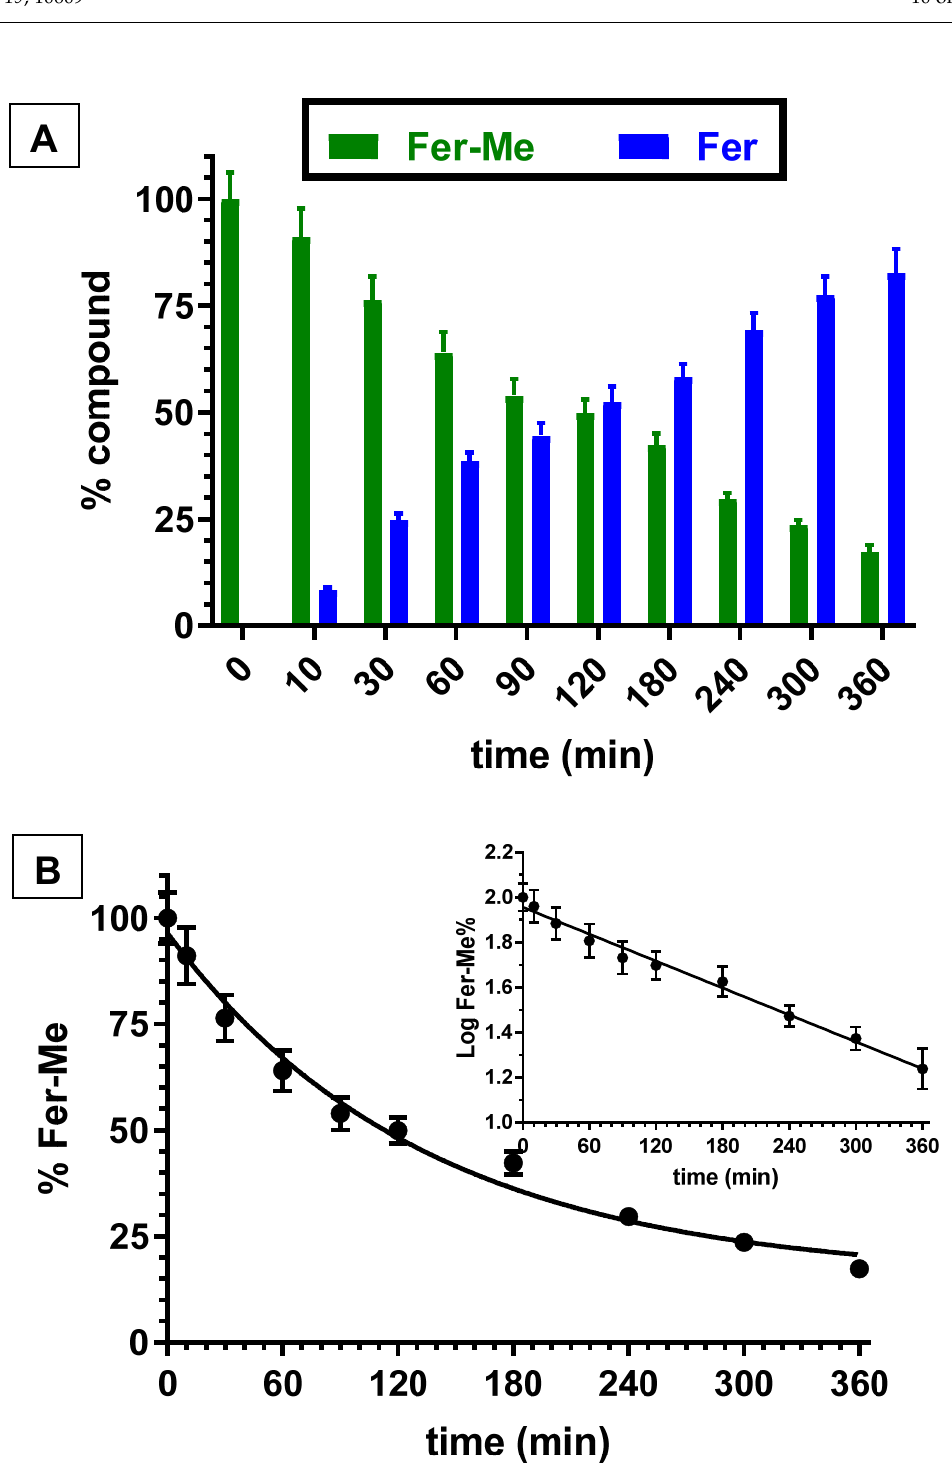
Figure 2. ( A ) Degradation profiles of the prodrug Fer-Me (green) and the corresponding appearance profiles of Fer (blue) in rat whole blood. All the values are reported as the percentage of the overall amount of incubated Fer-Me. Data are reported as the mean ± S.E.M. of three independent experiments. ( B ) Degradation profile of the prodrug Fer-Me in rat whole blood. Data are expressed as the mean ± S.E.M. of three independent experiments. The degradation followed a pseudo first order kinetic, confirmed by the semilogarithmic plot reported in the inset (n = 10, r = 0.994, p < 0.0001). The half-life of Fer-Me was calculated to be 92.4 ± 3.4 min.